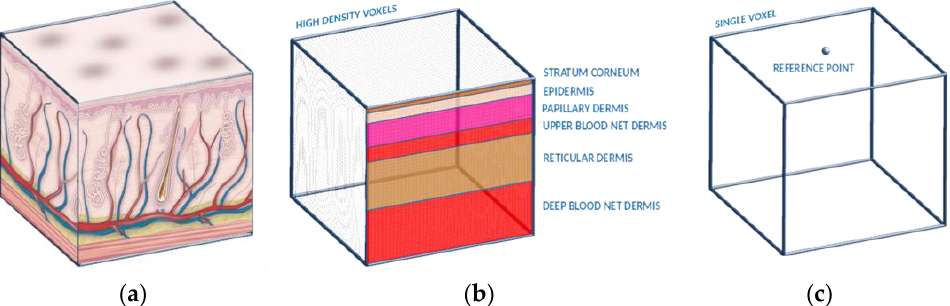
Figure 3. Conceptual illustrations of the ( a ) actual subdermal layers, ( b ) naive voxel generation method (a large number of voxels to faithfully replicate the actual effects of the dermal sublayers), and ( c ) proposed method of composite tissue (in a single voxel, the material properties are calculated during the runtime using the distance of the photon from the reference point(s)).